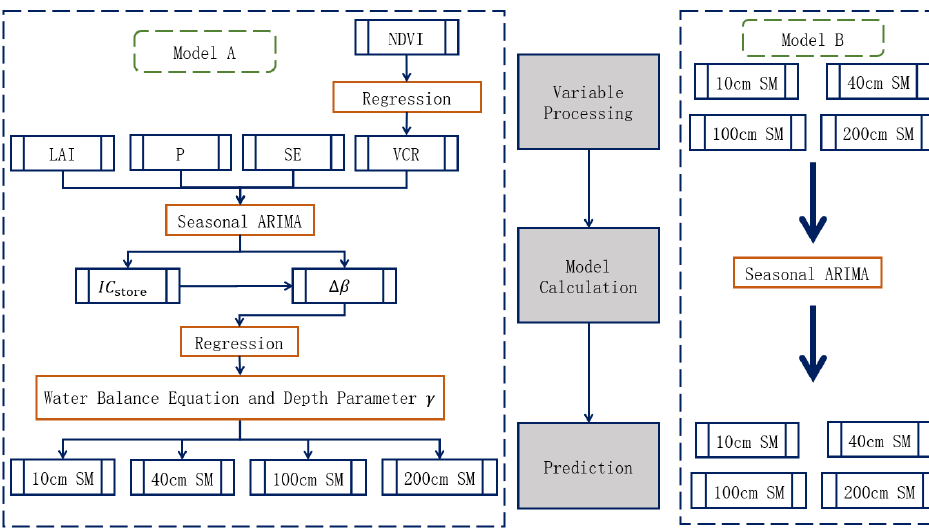
Figure 2. Empirical flow chart of the soil moisture prediction model .